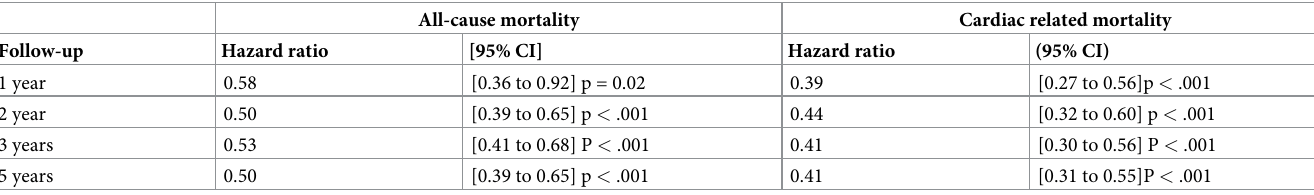
There was no statistically significant difference in 30-day mortality between the TAVI and medical therapy (TAVI versus medical therapy: 2.6% versus 5.9%, p = .09). Compared with medical therapy, TAVI was associated with a statistically significantly lower hazard of death of both all-cause and cardiac-cause at follow-up of 1, 2, 3 and 5 years (Table 2). More details are provided in the S5 Table. Table 2. Mortality: TAVI versus medical therapy in surgically inoperable